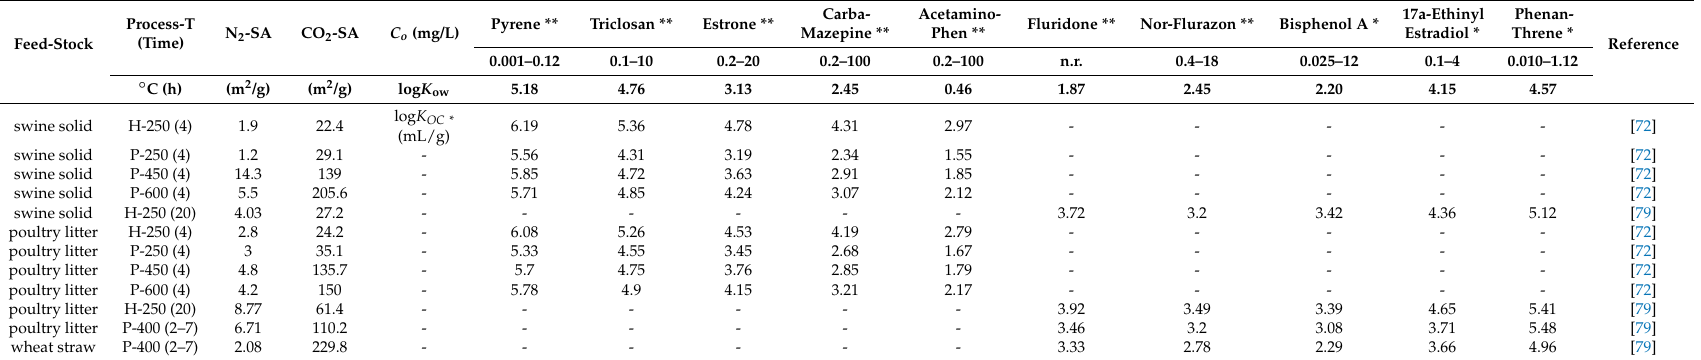
Table 4. Comparison of sorbent characteristics (maximum sorption capacities q c , surface area SA) for some hydrochars (H) and pyrochars (P) and the concentration-dependent distribution coefficients (log K OC ) from isotherm experiments with various organic compounds.